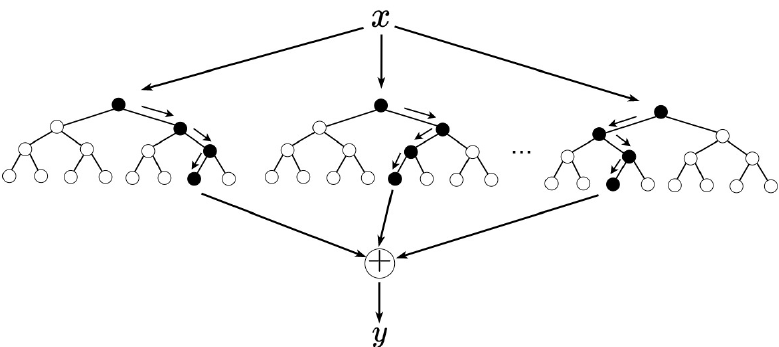
Figure 1. Schematic of the random forest model. (Source: author).